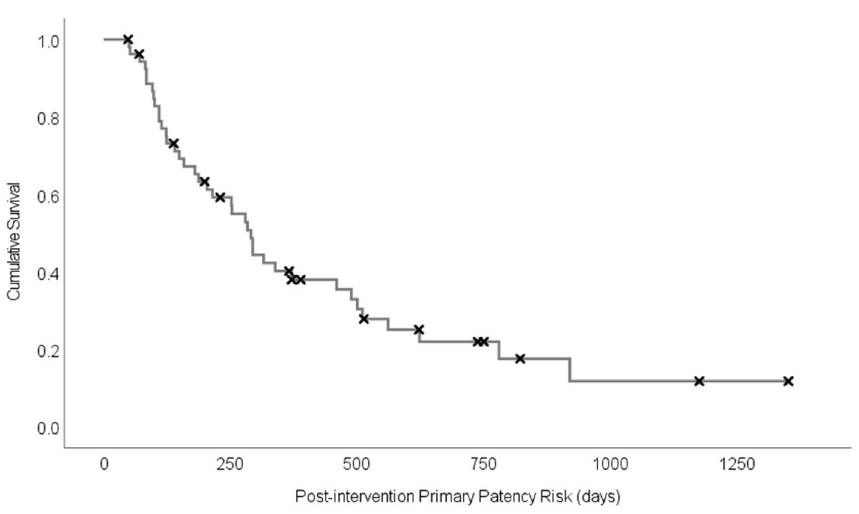
Figure 1. Kaplan–Meier plot of days to loss of post-intervention primary patency; X’s indicate patient